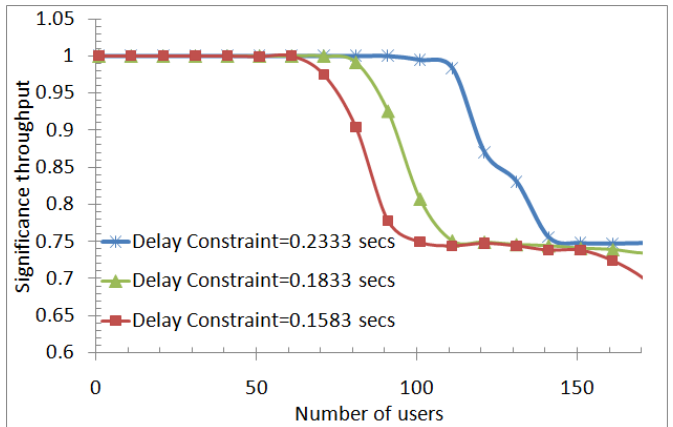
Figure 9. Significance throughput versus number of users for different maximum delay constraints, 20% of users and α = 0.25.